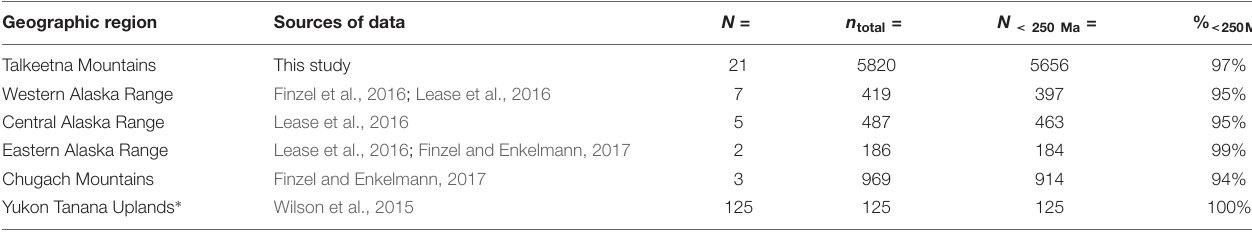
TABLE 1 | Data information for sediment source regions. Geographic